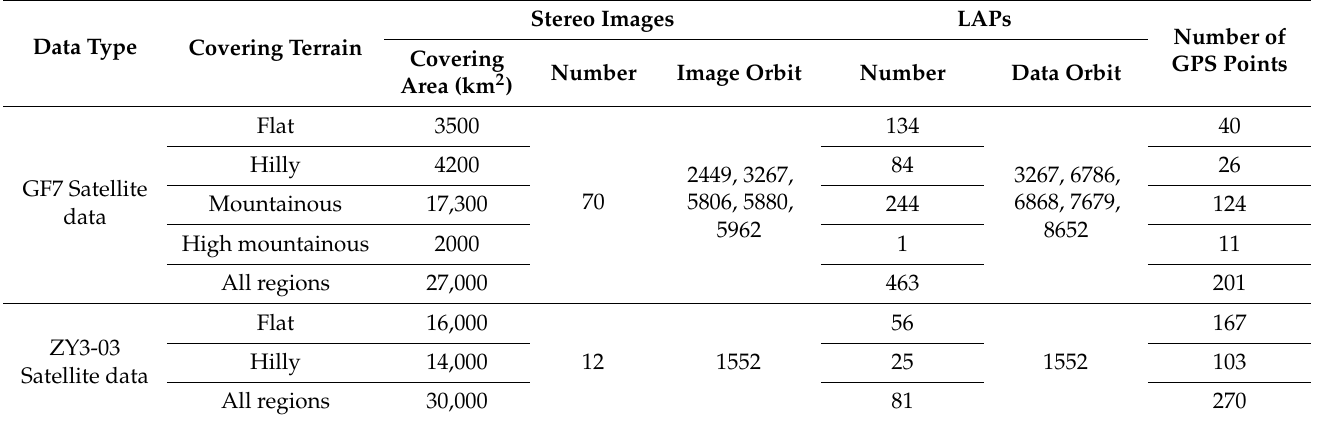
Table 1. Characteristics of the experimental data used in this